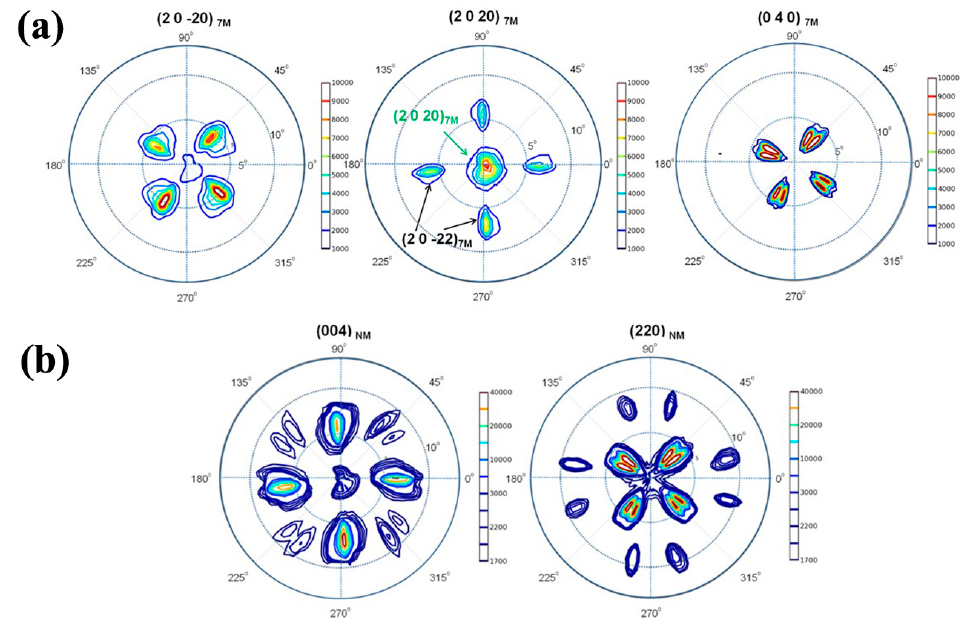
Figure 12. Pole figures determined from XRD measurements for 7M and NM martensite in Ni 50 Mn 30 Ga 20 thin film: ( a ) {2 0 − 20} 7M , {2 0 20} 7M and {0 4 0} 7M pole figures; and ( b ) {0 0 4} NM and {2 2 0} NM pole figures.